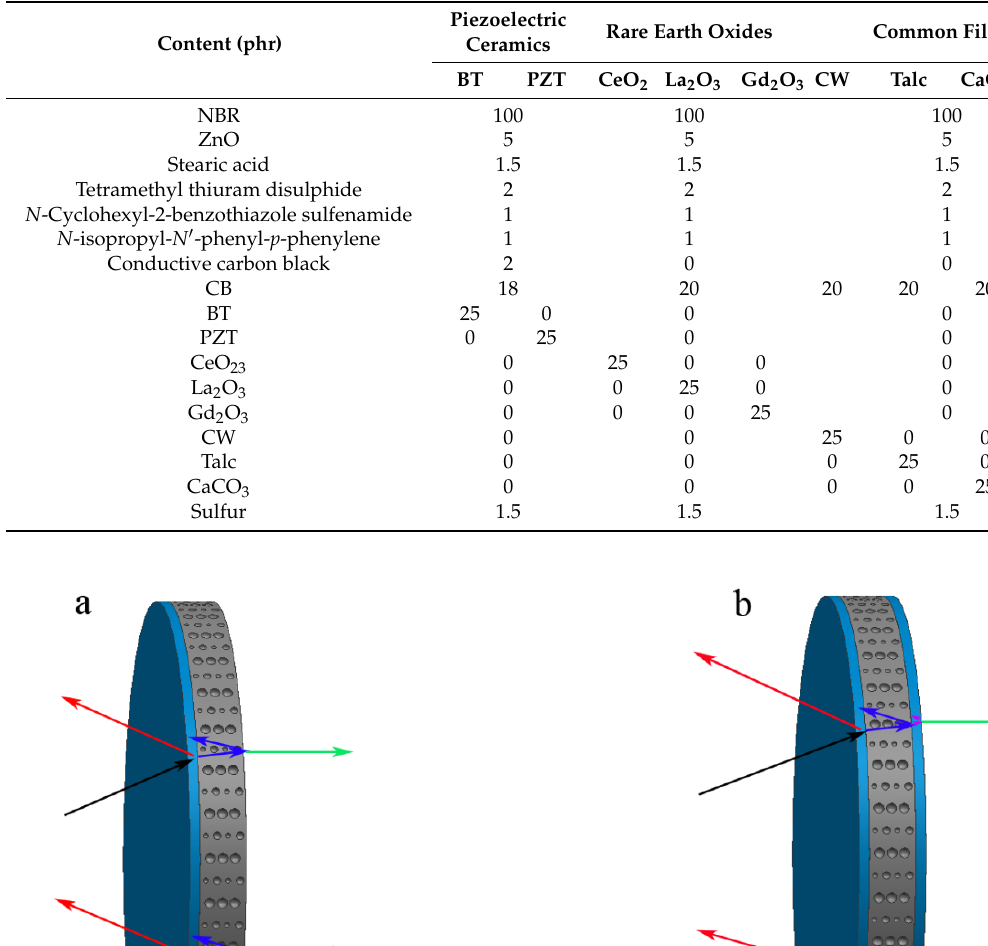
Table 1. Formulation of the compounds.